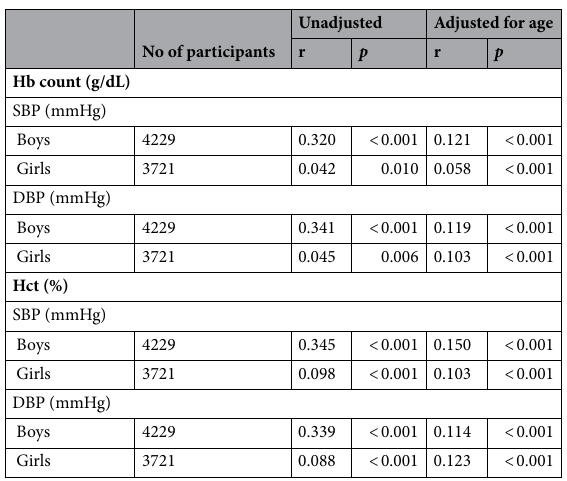
Table 3. Unadjusted and adjusted correlations between hemoglobin count and hematocrit, and blood pressure in children and adolescents 10–18 years old ( n = 7950). Hb hemoglobin; Hct hematocrit; SBP systolic blood pressure; DBP diastolic blood